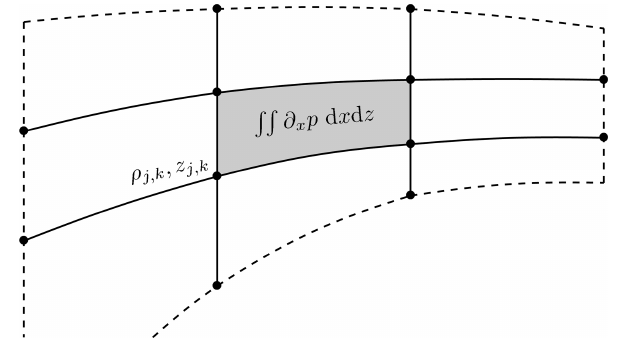
Figure 3. Stencil for the isopycnal slope and pressure-gradient scheme given by Shchepetkin and McWilliams (2003). The points indicate the buoyancy (density) points. The solid lines are the re- constructed coordinate lines used in the horizontal calculation, and the shaded area shows the area integral of the horizontal buoyancy